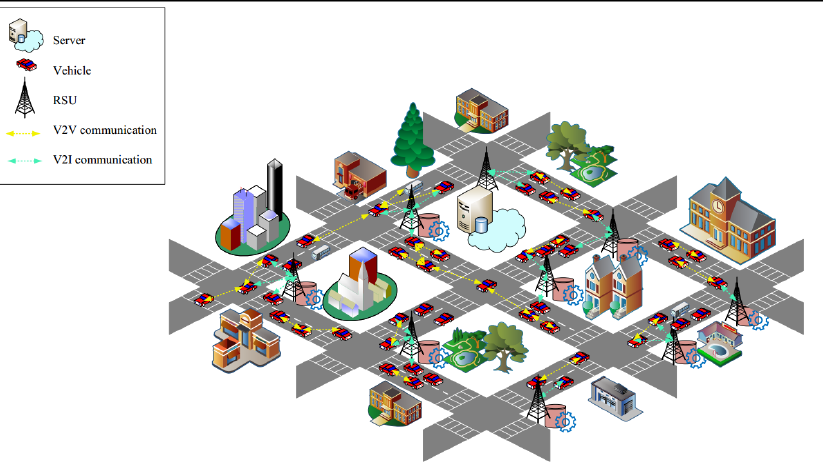
Figure 3. Network model in the proposed